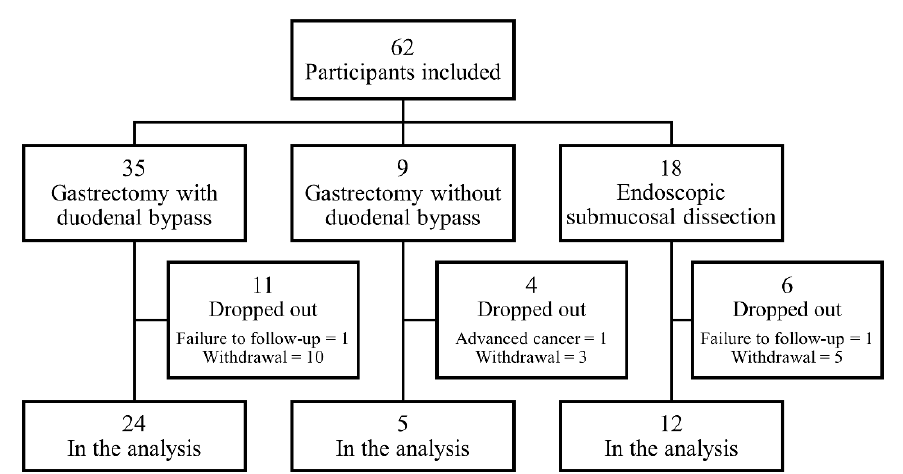
Figure 1. Flow chart of the study. Table 1. Baseline characteristics of patients included in the